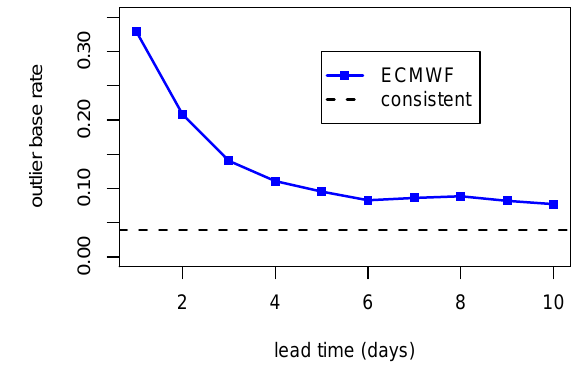
Figure 2. The markers indicate outlier base rate over lead time for the ECMWF temperature ensemble. The time period is 2001–2006 and the location is Dresden, Germany. The dashed line indicates the outlier base rate 2 / 51 of a consistent 50-member